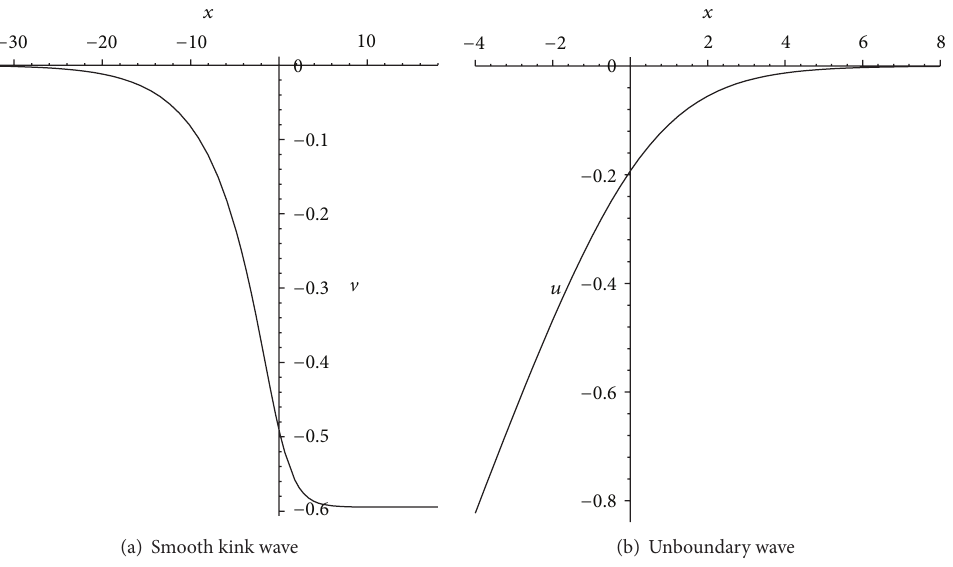
Figure 2: The phase portraits of solutions (42) and (43) for 𝑚 = 4, 𝛼 = 0.3, 𝛽 = −0.3, 𝑐 = 2, 𝑡 = 0.1 .